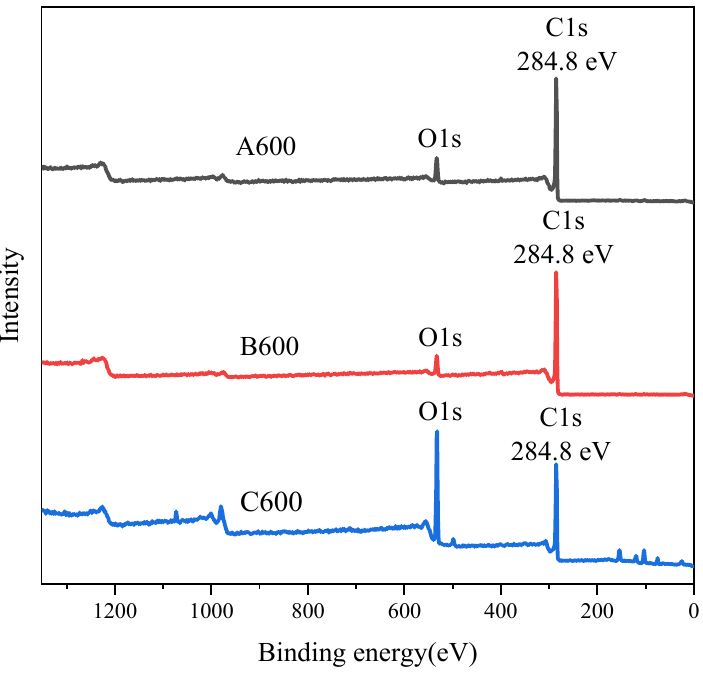
Figure 7. Survey spectra of three coal chars pyrolyzed at 600 °C.